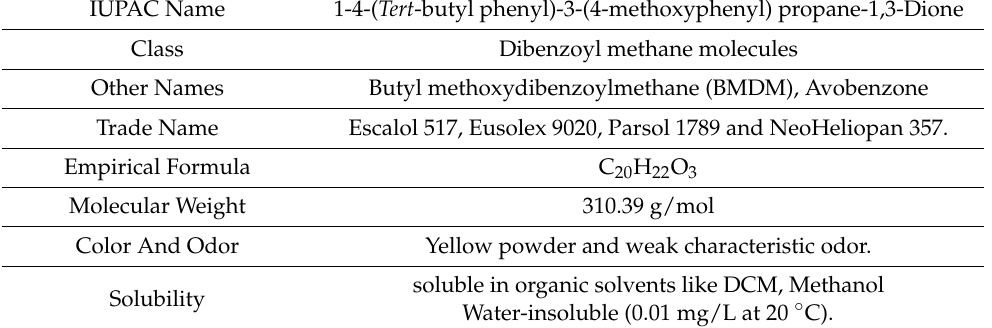
Table 1. Avobenzone